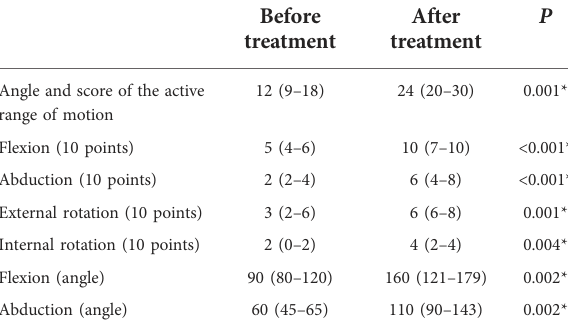
TABLE 3 Comparison of the active range of motion in the thickening group before and after